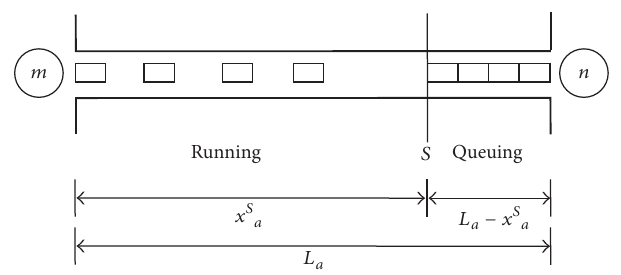
Figure 1: Schematic representation of an arc.